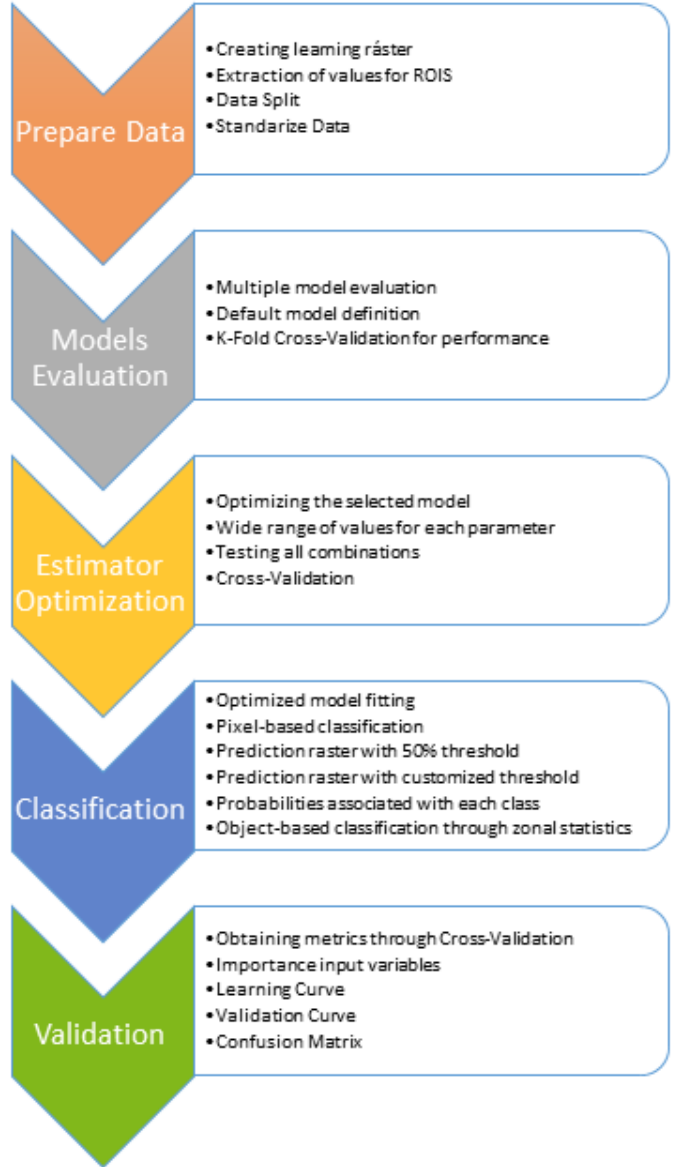
Figure 6. Stages of the developed methodology and their main